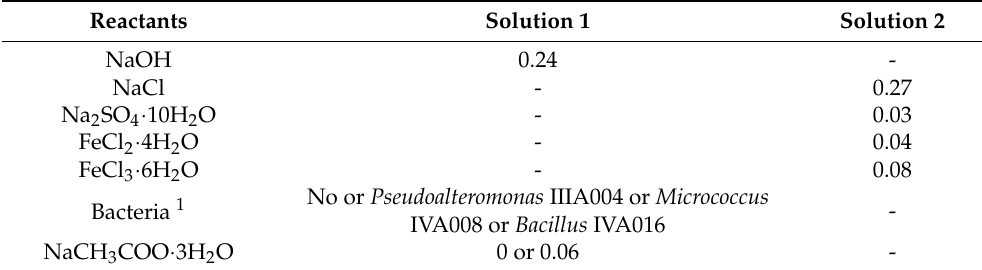
Table 1. Concentrations of reactants used to prepare the initial green rust precipitate (mol L − 1 ), expressed with respect to the total volume of solution (200 mL = solution 1 + solution 2), and considered bacterial